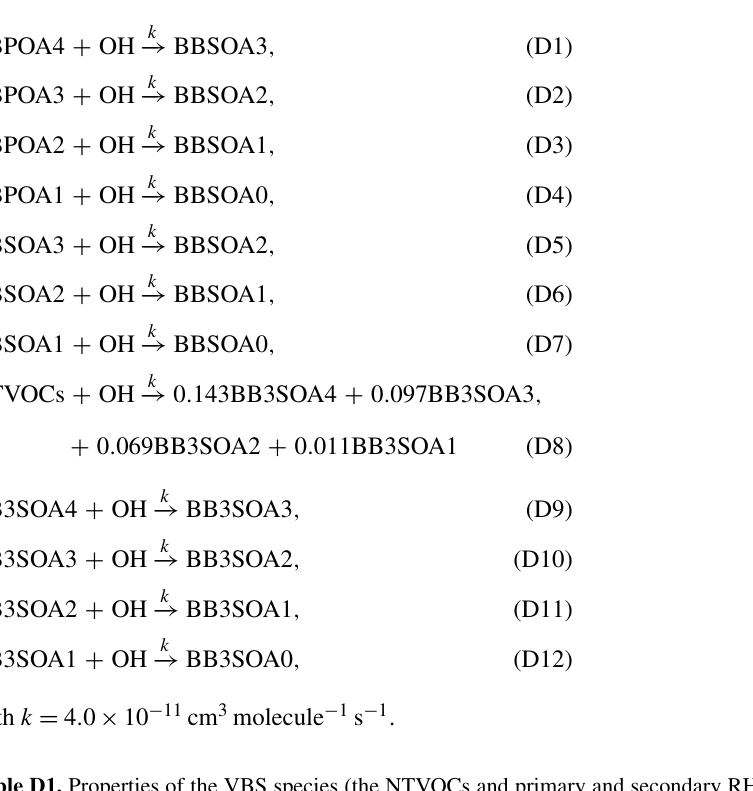
Table D1. Properties of the VBS species (the NTVOCs and primary and secondary RH-I/S-VOCs). The molecular weights are in gmol − 1 . (cid:49) H vap is the enthalpy of vaporization in KJmol − 1 , which describes the temperature dependance of the saturation pressure C ∗ . Surrogate Emission fraction Molecular